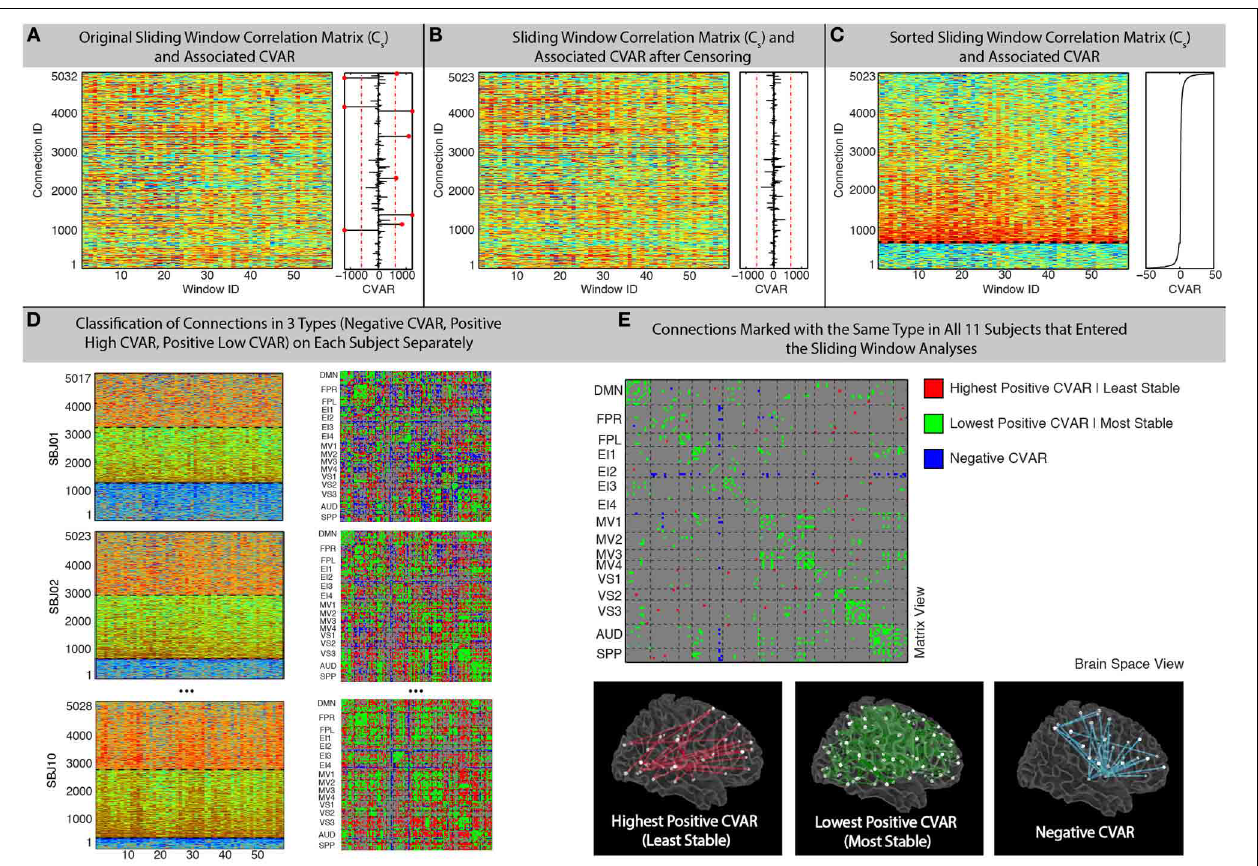
FIGURE 2 | Sliding-Window methods. (A) Example running window connectivity matrix for one representative subject on the left, and its associated vector of CVAR values on the right. The thresholds used to discard connections on the basis of excessive CVAR are depicted as red dashed lines. Eight connections that were discarded for this particular subject are marked as red dots. (B) Sliding window connectivity matrix and CVAR vector after removal of outlier connections. Now there are 5023 connections, instead of 5032, for this representative subject. (C) Sliding window connectivity matrix and CVAR vector after sorting connections according to their CVAR. Connections with negative CVAR are at the bottom of the graph, while connections with positive CVAR are on the top. The further a connection is from the horizontal axis where